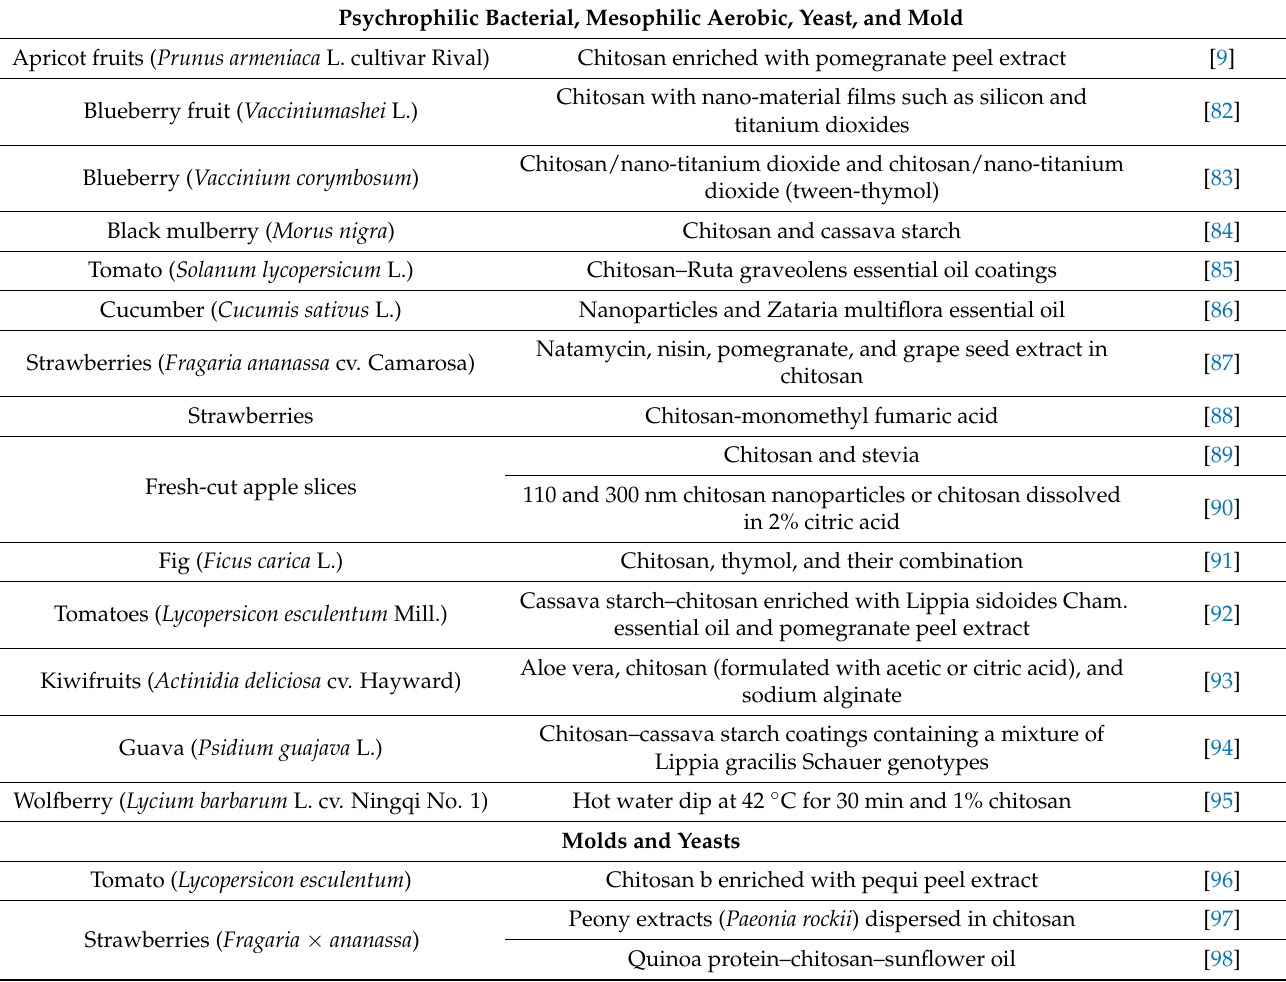
Table 4. Published results from bacterial and fungal contamination by different microorganisms in fruits: from 2011 to 2021. Psychrophilic Bacterial, Mesophilic Aerobic, Yeast, and Mold Apricot fruits ( Prunus armeniaca L. cultivar